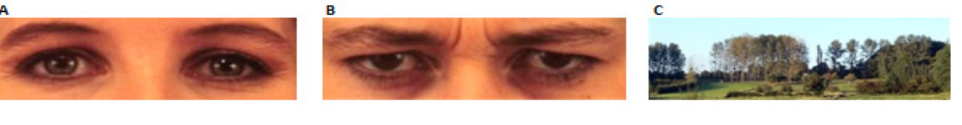
The difference in money earned between unilateral defection and mutual cooperation.